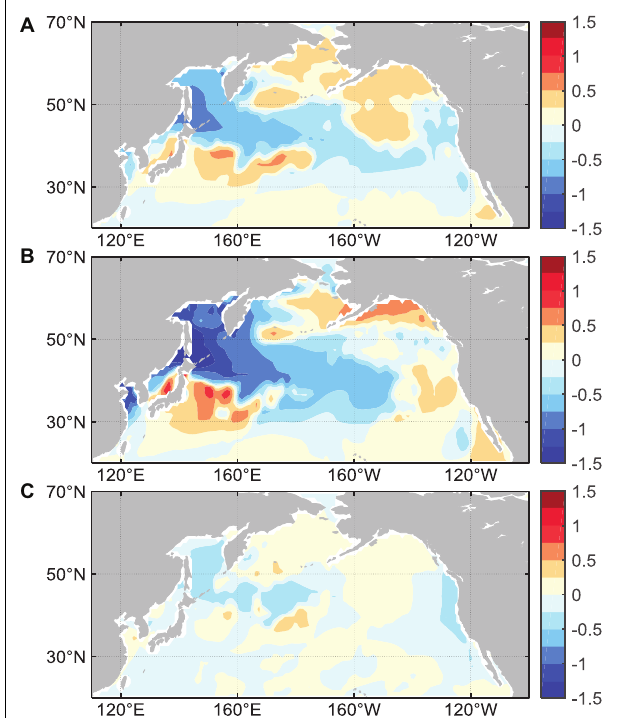
FIGURE 10 | The differences of absolute predicted biases between Exp.wave and Exp.nowa in 2016. (A) Annual mean; (B) Jan-Jun mean; and (C) Jul-Dec mean. The hindcasts with or without wave are respectively compared with OISST v2 to show the predicted biases. Then the difference of absolute values of the biased between Exp.wave and Exp.nowa are calculated. As definited above, the negative value, indicating that the absolute difference between EAKF and observation is smaller than that between Projection-OI and OISST v2, represents the improvement due to the surface wave